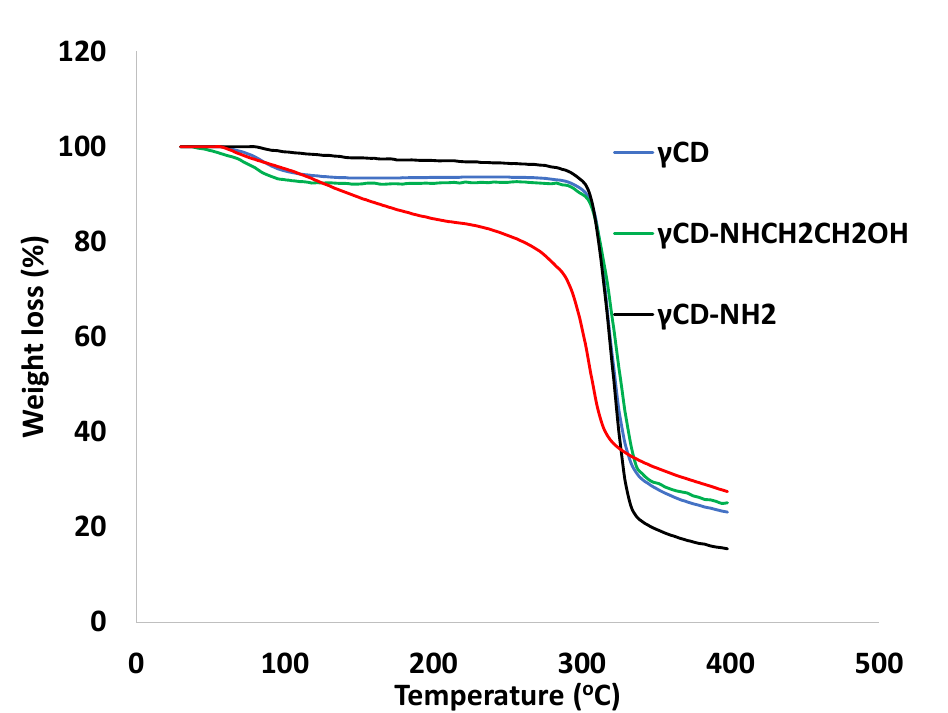
Figure 3. TGA thermograms of γ-CD-NHCH 2 CH 2 OH, γ-CD, γ-CD-NH 2 , and γ-CD-NHCH 2 CH 2 NH 2 .